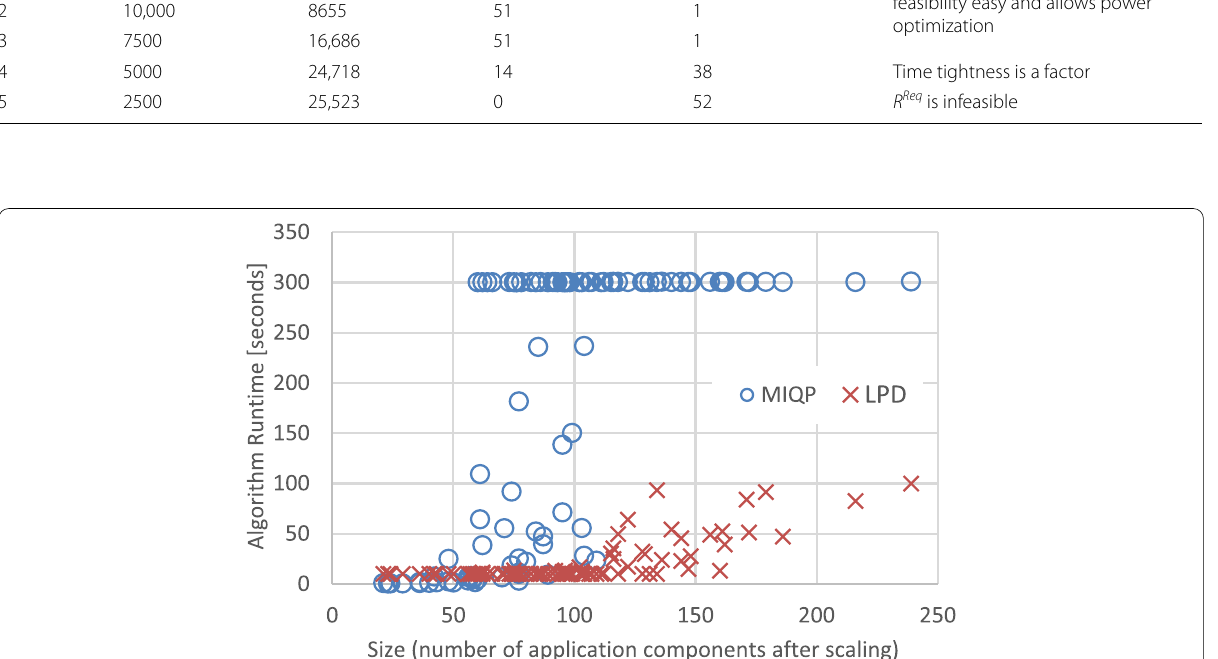
Fig. 9 Algorithm runtime versus problem size for the LPD and